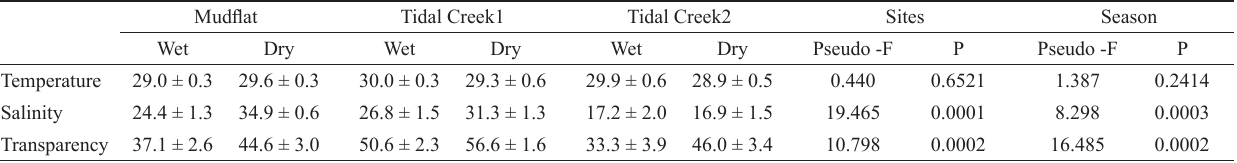
Tab. 1. Environmental parameters are displayed as mean ±SE (Standart error). Levels of significance for differences for sites